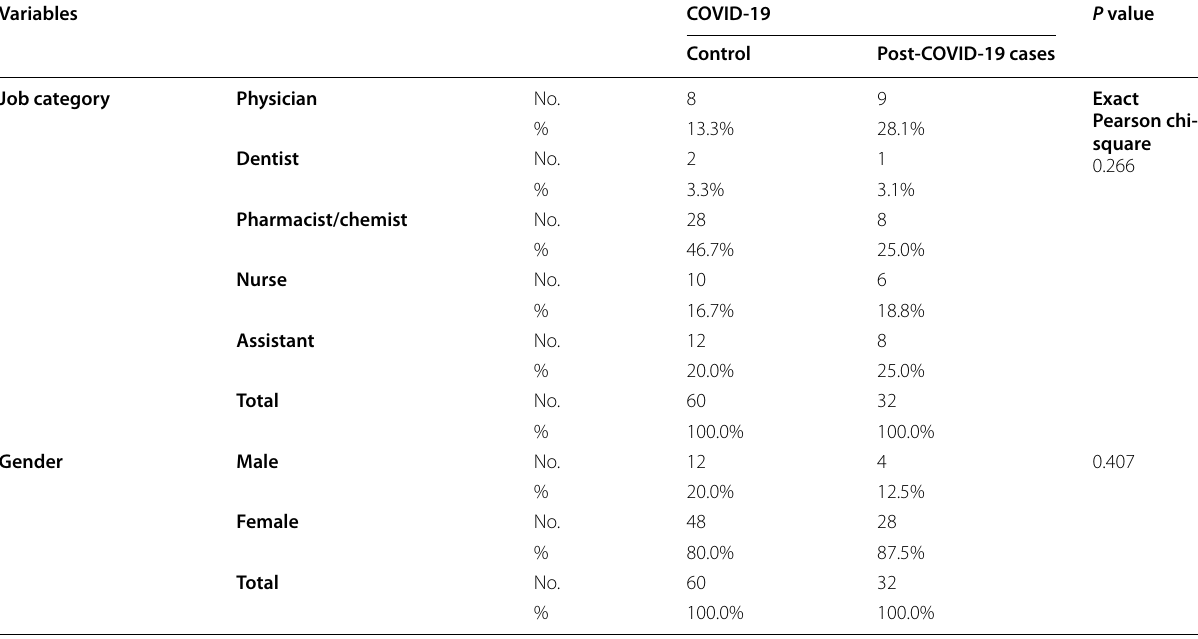
Table 1 Descriptive analysis of the post‑COVID‑19 cases and control group according to their gender and various job categories Variables